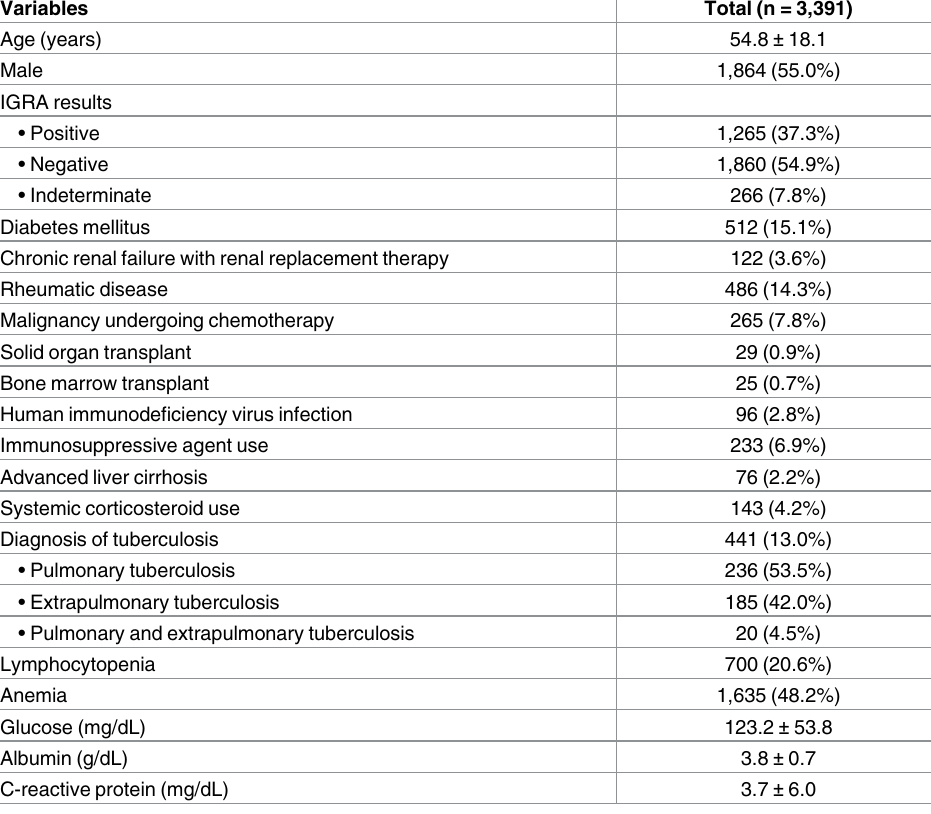
Table 1. Baseline characteristics of enrolled